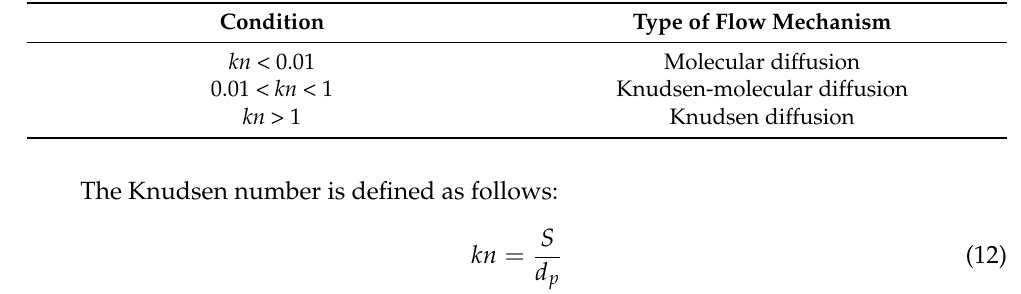
Table 2. Types of mass transfer mechanisms based on Knudsen number [13], Reproduced with permission from [Morteza Aliabadi], [Processes]; published by [MDPI AG],